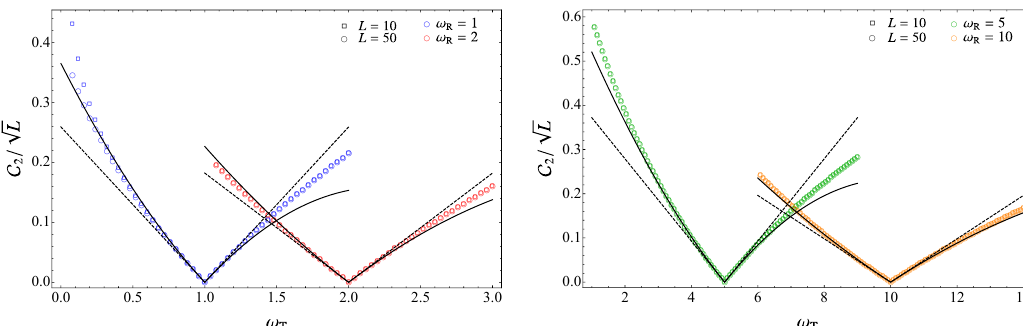
Figure 5 . The complexity C 2 between the ground states of harmonic chains with κ = m = 1 and different frequencies, for a given ω dashed lines correspond to the first order approximation (9.32) and the solid lines to the second order approximation (9.33), in the thermodynamic limit and in the expansion where ˜ ω